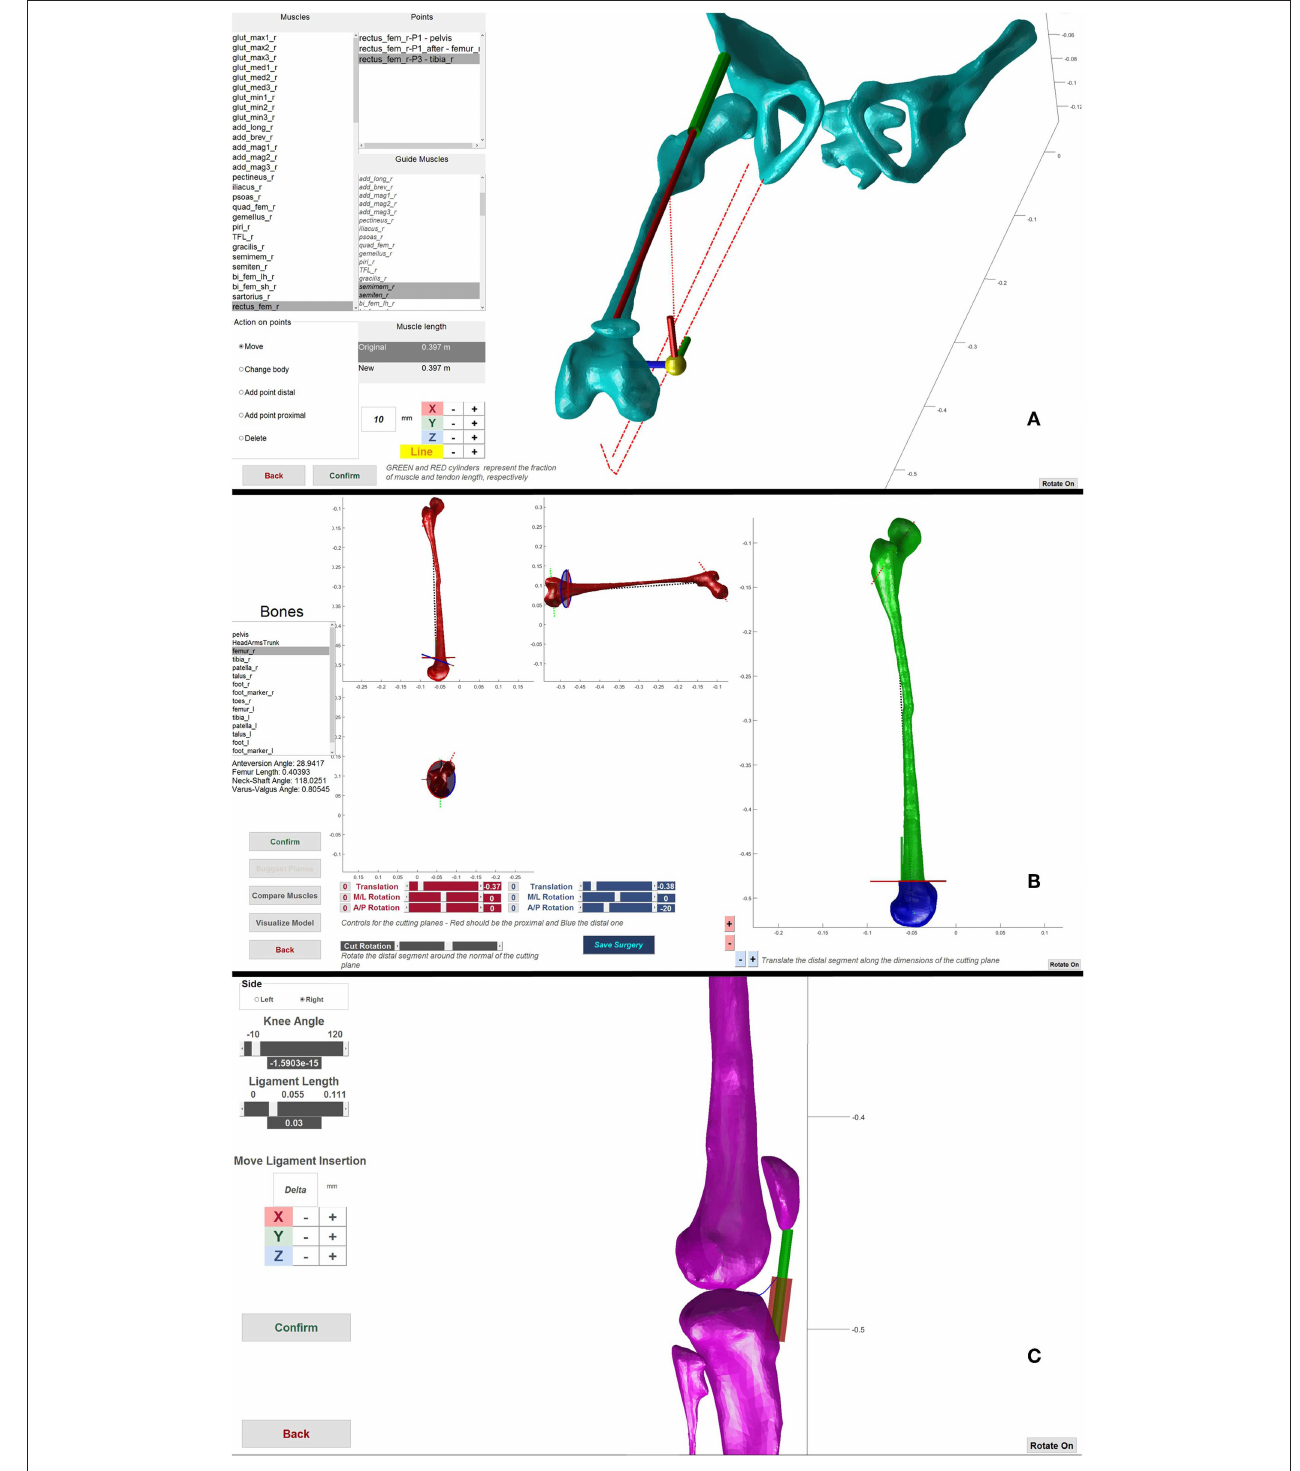
FIGURE 2 | Framework components. (A) Muscle transfer surgery. Used to change the path of a muscle. The lines of action of other muscles are visualized as guide to help during the transfer. (B) Extension and Derotation osteotomy surgery. Two sets of scrollbars define the pose of the two cutting planes (red and blue in the left side figures) that define the wedge of bone to be removed. After wedge removal, the two segments are brought in contact and it is possible to rotate and translate the distal part to correct for abnormal anteversion angles. (C) Patella advancement surgery. It is possible to define the new length of the patella ligament and/or move its insertion on the tibia, during the operation the ligament in the new configuration is shown as a red cylinder.